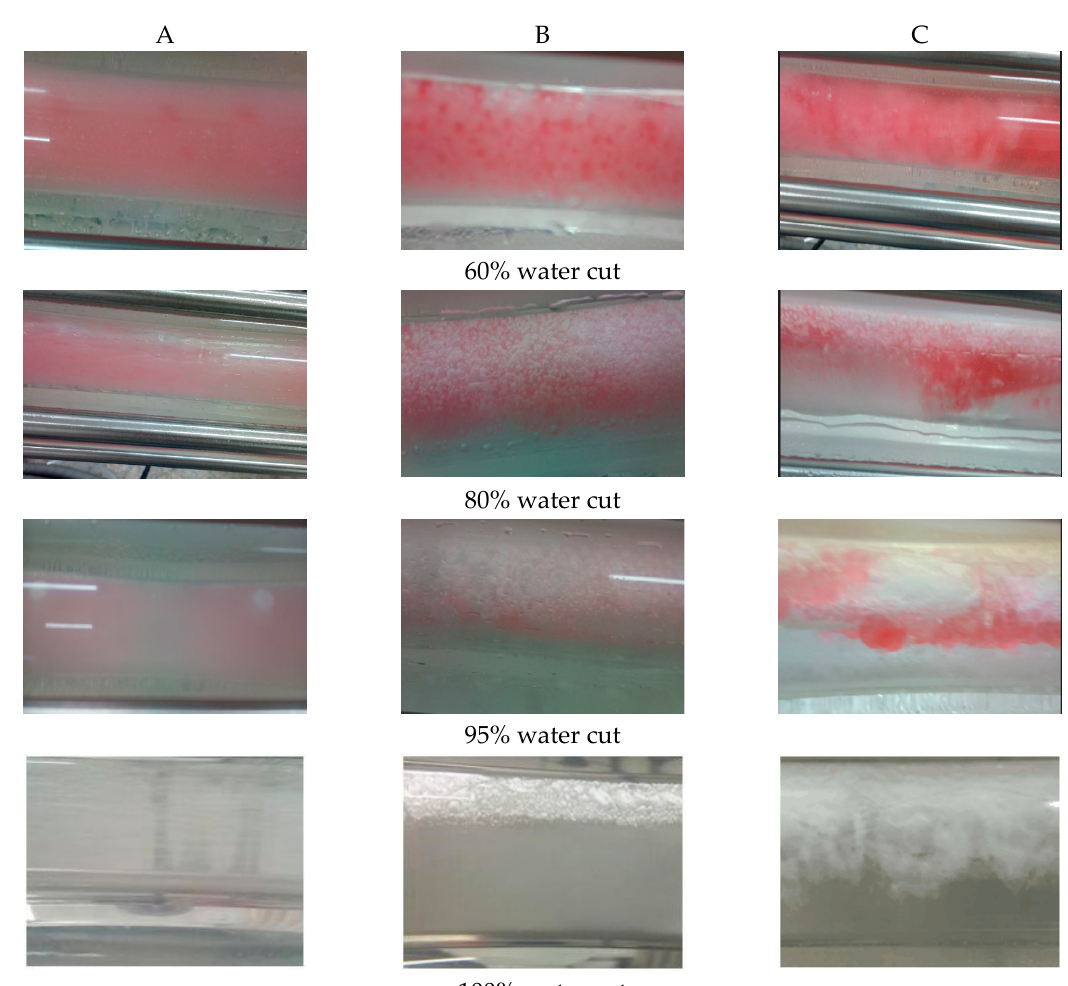
Figure 4. Flow pattern in the pipeline at different water cuts.